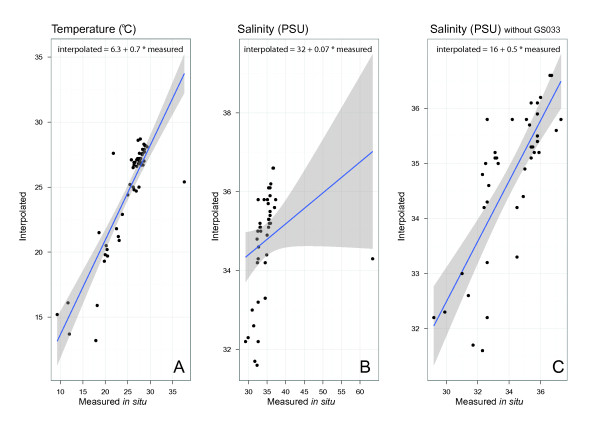
Linear regression analysis of measured and interpolated environmental parameters. Temperature (A), salinity (B) and salinity with sample GS033 removed (C). The points represent the samples. The solid blue line is the fitted linear function and the shaded area depicts the confidence interval for it.